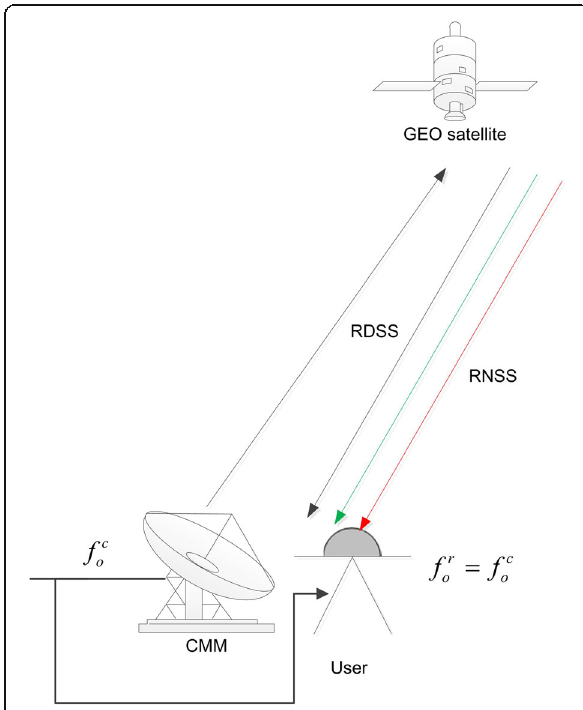
Fig. 3 Precise time and frequency transmission between MCS and